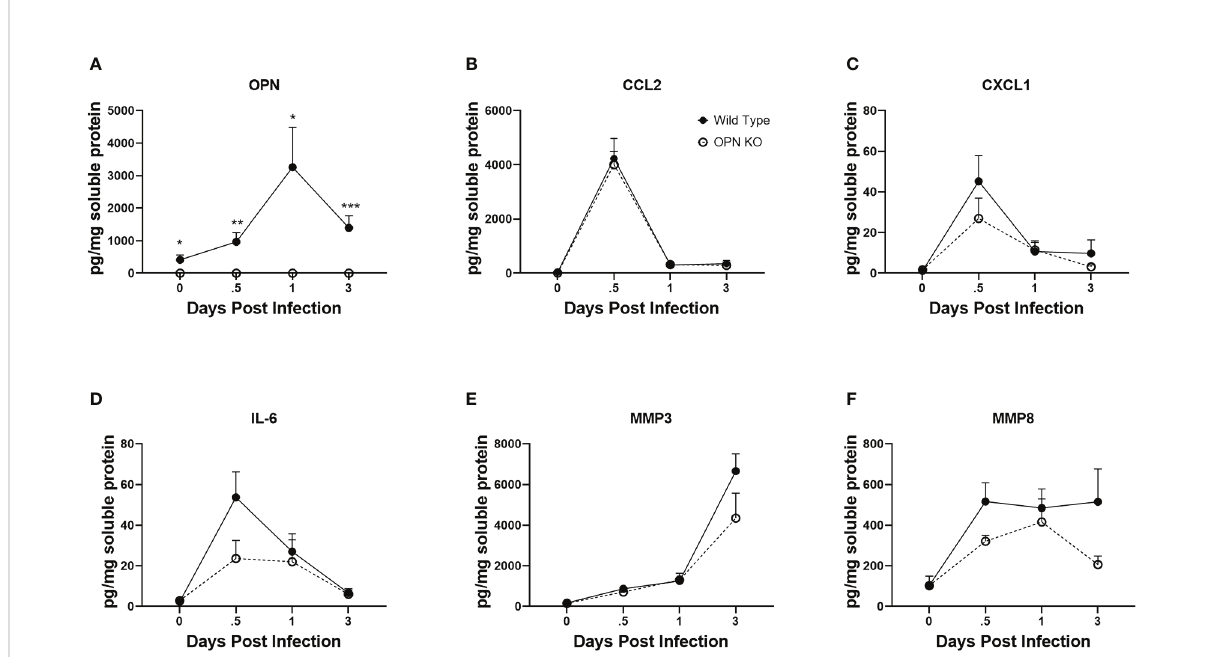
FIGURE 6 Select cytokine/chemokine levels are not altered in the cornea of OPN KO mice. WT and OPN KO male and female mice (n=5-6/group) were infected with HSV-1 (350 PFU/cornea). At the indicated time point PI, corneas were removed from the mice and processed for analyte expression including (A) OPN, (B) CCL2, (C) CXCL1, (D) IL-6, (E) MMP3, and (F) MMP8 by multiplex suspension array analysis. Each point represents the mean ± SEM ***p<.001, **p<.01, and *p<.05. Uninfected mice served as controls and are represented at the day 0 post infection time